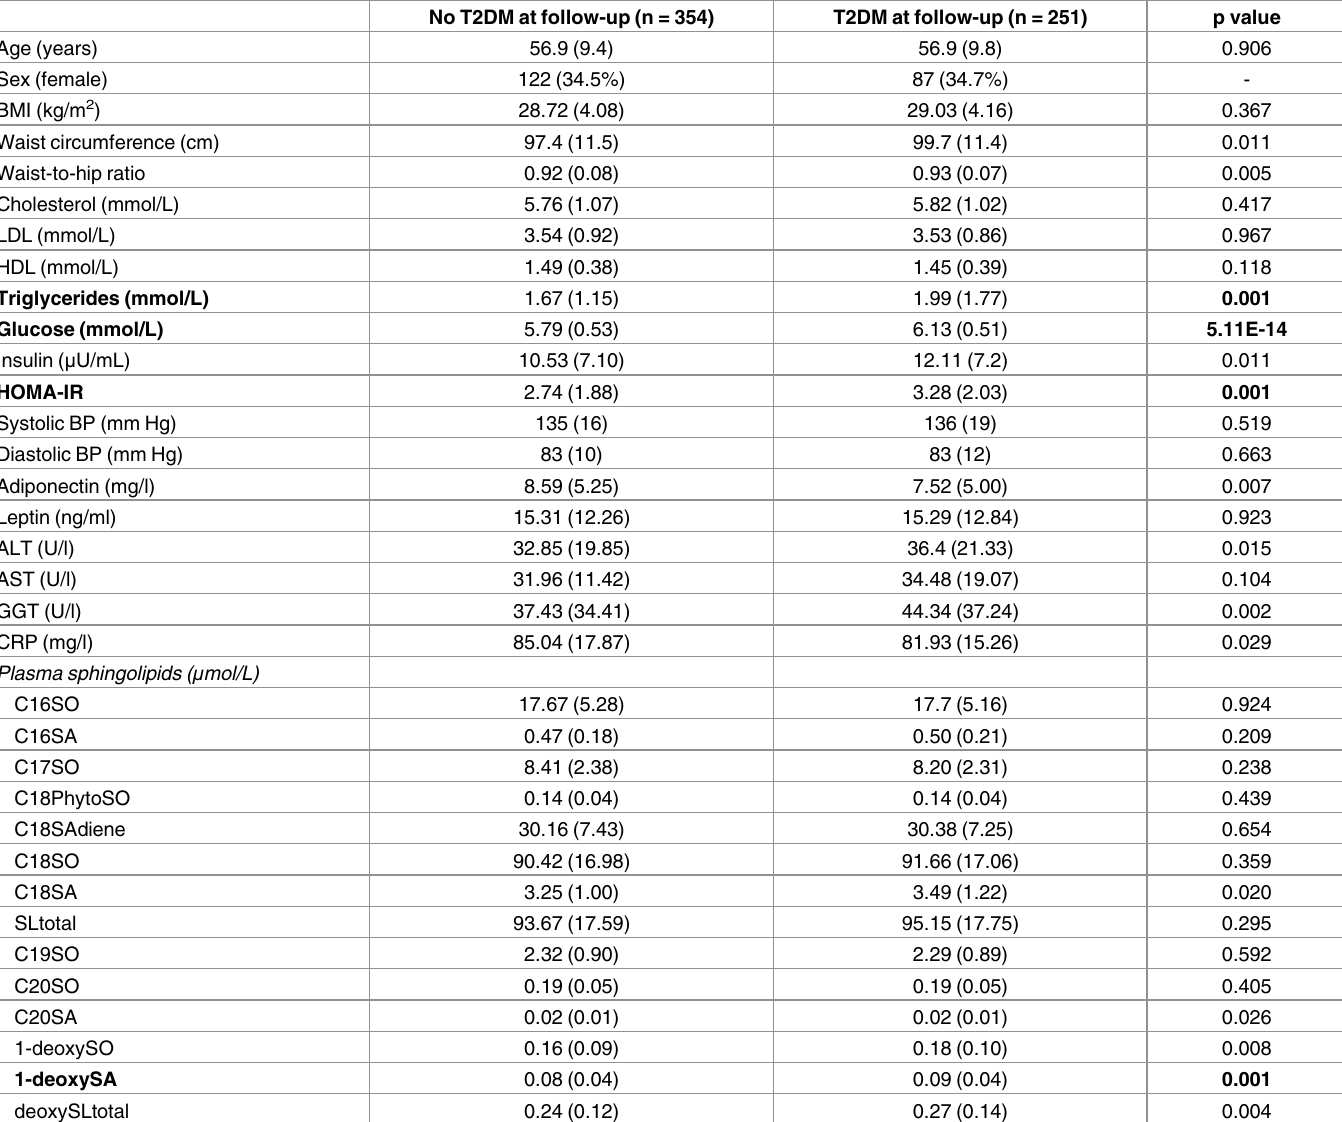
Table 1. Baseline values of clinical parametersand sphingolipids levels in the incident and non-incident T2DM group. No T2DM at follow-up (n = 354) T2DM at follow-up (n =